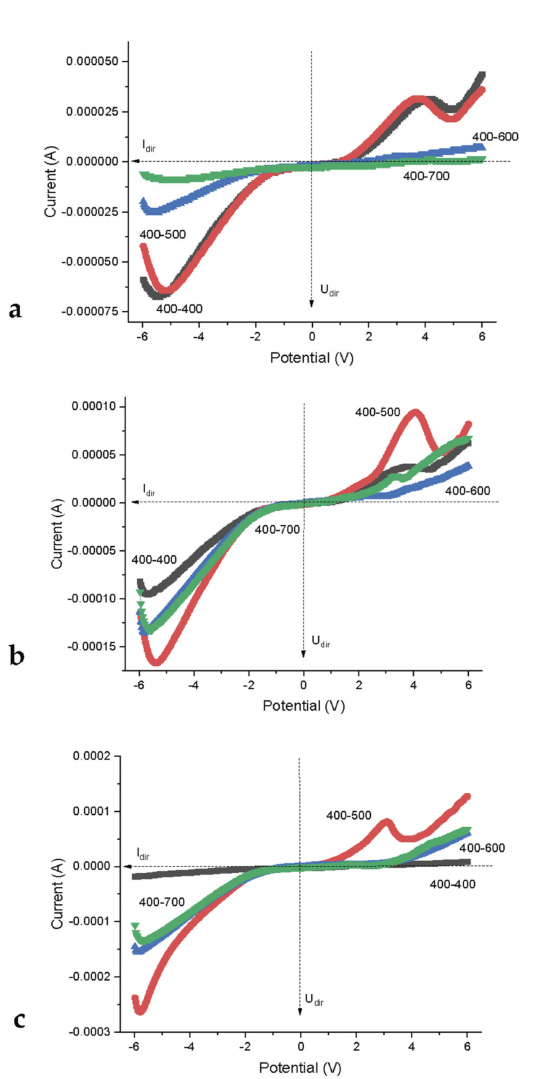
Figure 5. Families of curves A - I of contacts of chemically identical samples (ZrO 2 -3 mol% Y 2 O 3 ) with identical size of particles 7.5 nm (curves 400–400) and samples with different size of particles: 7.5 nm–9 nm (curves 400–500); 7.5 nm–11 nm (curves 400-600); 7.5–14 nm (curves 400–700) at relative atmospheric humidity 60% ( a ), 76% ( b ) and 86% ( c